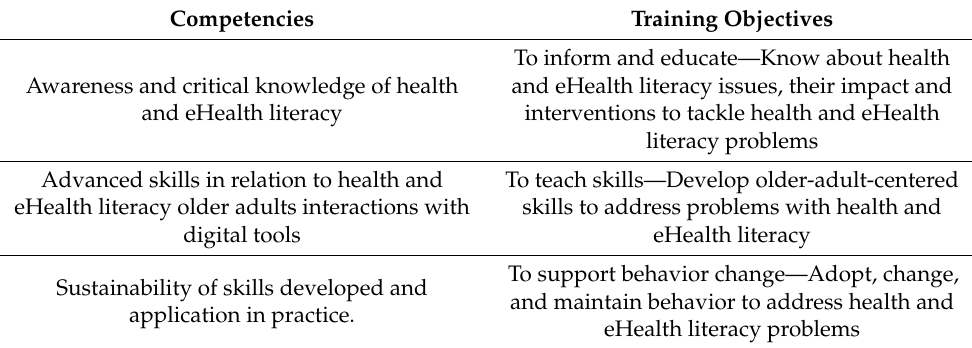
Table 1. The three learning competencies of the European Qualifications Framework (EQF). Competencies Training Objectives Awareness and critical knowledge of